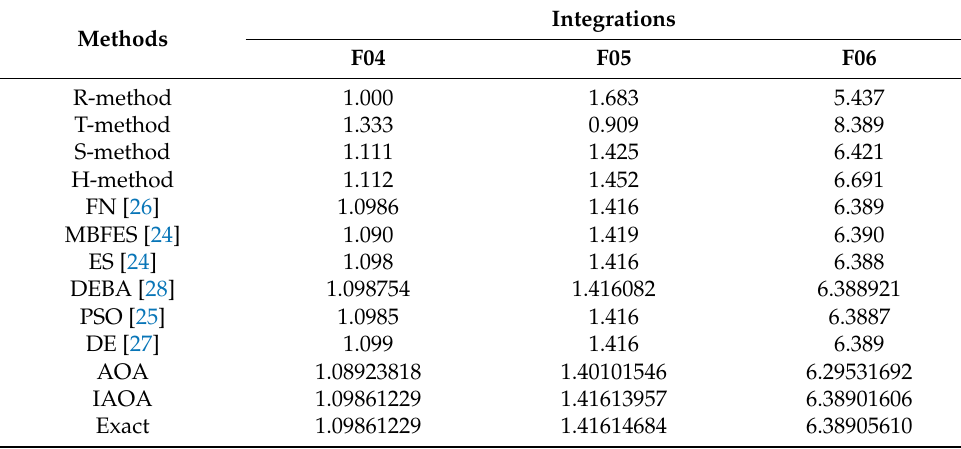
Table 10. Comparison of the experimental results for F04–F06.